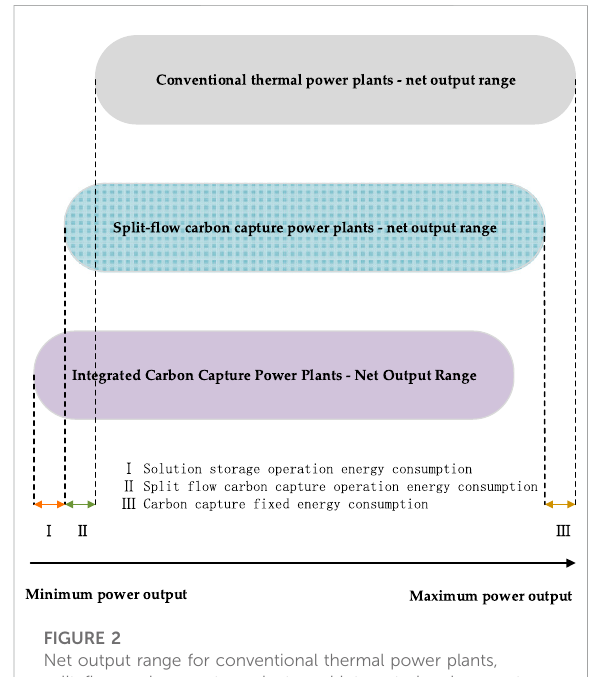
FIGURE 2 Net output range for conventional thermal power plants, split- fl ow carbon capture plants and integrated carbon capture